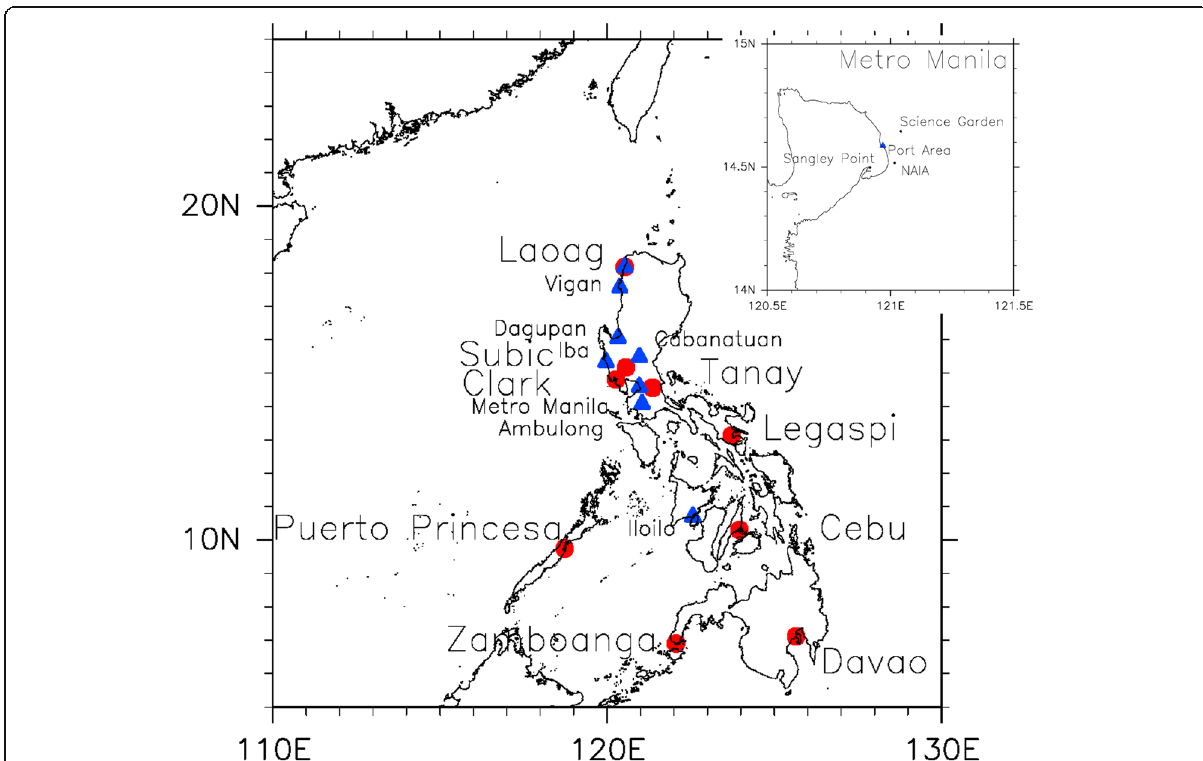
Fig. 1 Locations of observation stations. Upper-air observation stations (red dots with large station name) and surface rainfall observation stations (blue triangles with small station name) used to define Philippine monsoon